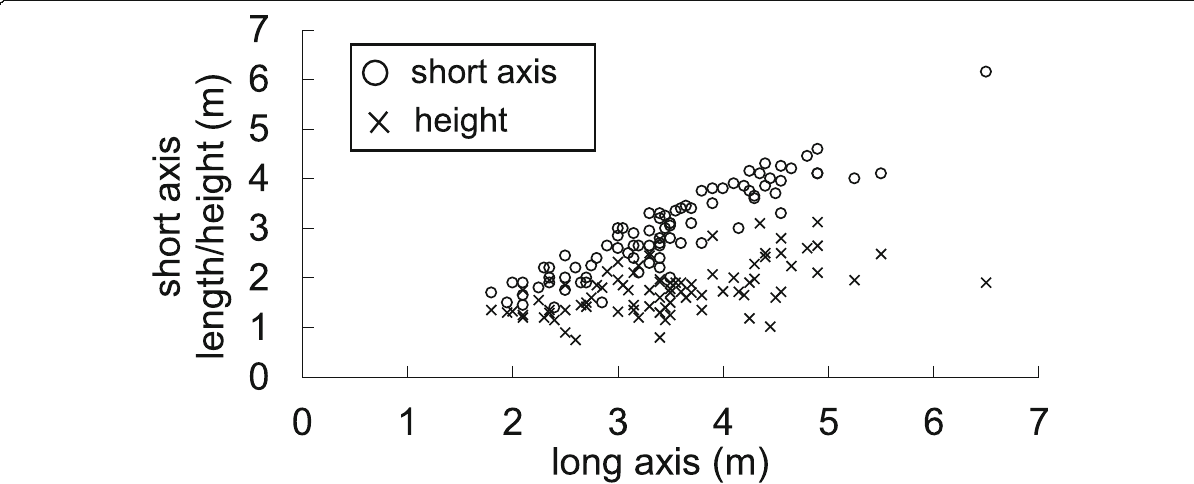
Fig. 5 A diagram showing the relation between long and short axes lengths and height of the living massive corals of Porites spp. See Table 1 for the list of original